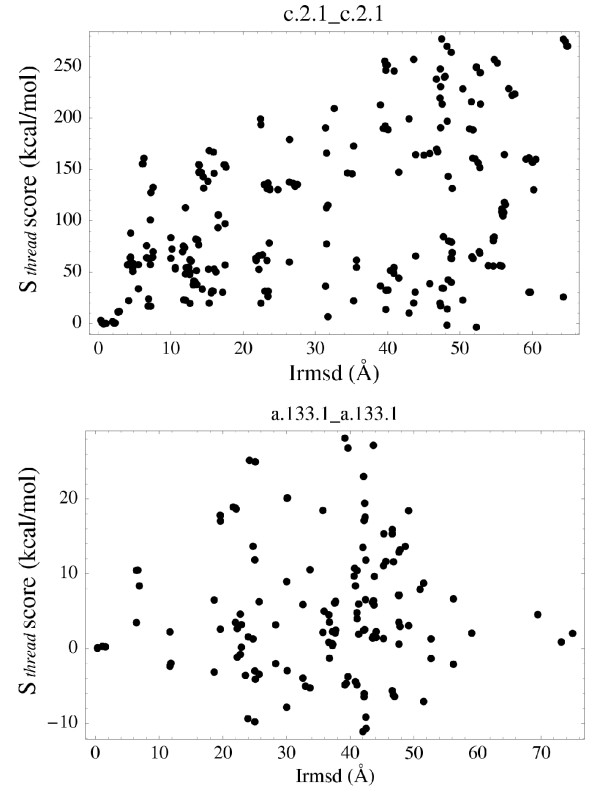
Sthread vs. Irmsd relative to the Xray structure. Representation of all the modelled complexes within the c.2.1 (top) and a.133.1 (bottom) groups.